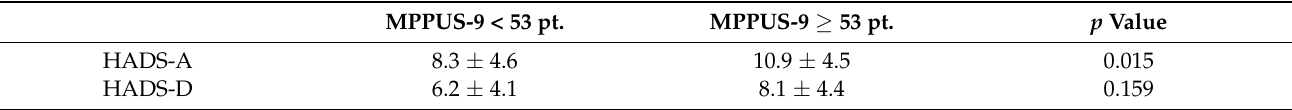
Table 4. Group comparison between individuals that meet the criteria for phonoholism (MPPUS-9 ≥ 53) and a group of participants that does not meet the criteria for phonoholism (MPPUS-9 < 53) regarding HADS scale results. Mann–Whitney U test was performed for quantitative variables and Fisher’s exact test was performed for qualitative